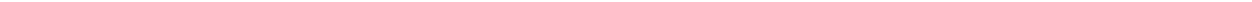
Figure 1 | CDK4/6 inhibition induces ROS-mediated senescence and autophagy. ( a ) IC 50 values of palbociclib in ER þ (MCF7, T47D, ZR75-1) and HMEC (MCF10A) cells treated with increasing concentrations of palbociclib (0.01–12 m M). MCF7, T47D and MCF10A cells were treated with DMSO (Cnt) or palbociclib for 6 days, allowed to recover (rel) and subjected to ( b ) Clonogenic assay, ( c ) Cell counting and ( d ) SA- (cid:2) galactosidase activity measurement with representative images. ( e ) Impact of combined siRNA knockdown of CDK4 and CDK6 along with treatment with DMSO, 1 or 5 m M palbociclib for 6 days. ( f ) Measurement of MDC-positive acidic vesicles, including autophagosomes, by flow cytometry in MCF7 and T47D cells treated siRNA against CDK4/6. ( g ) Western blot for LC3B I, II and p62 upon treatment with palbociclib for 6 days. ( h ) Representative TEM microphotograph of cells treated with DMSO (Cnt) or 1 m M palbociclib for 6 days. Red arrows indicate double-membraned autophagosomes. Scale bars, 500nm. ( i ) Western blot of LC3B and p62 in MCF7 and T47D cells treated with a combination of 25 m M CQ for 1h and palbociclib for 6 days. ( j , k ) Quantification of GFP-LC3 puncta ( j ) and RFP-GFP-LC3 puncta ( k ) and representative images in MCF7 cells treated with 1 m M palbociclib and/or 25 m M CQ for 48h. ( l , m ) Cellular ROS measurement and quantification (MFI) of ROS levels in MCF7 and T47D cells upon transfection with siRNA against CDK4 and CDK6 ( l ) or treatment with palbociclib for 6 days ( m ). ( n , o ) LC3B and p62 protein levels ( n ) and MDC þ ve cells ( o ) upon combined treatment with 10mM NAC or 0.1mM Trolox and 5 m M palbociclib for 6 days. All data represent mean ± s.d. from three independent experiments; P values were calculated in comparison with cells treated with DMSO (Control) unless indicated. NS: P 4 0.05; * P o 0.05; ** P o 0.01; *** P o 0.001; **** P o